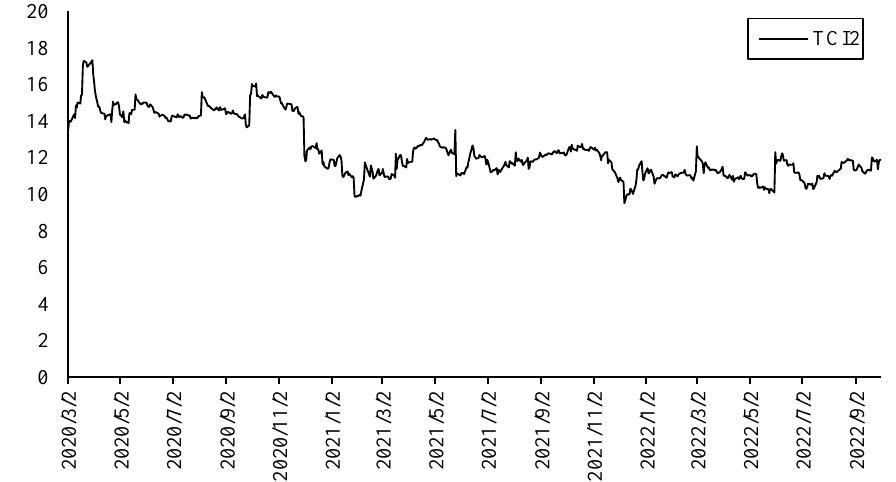
Figure 8. TCI of the second layer (different markets under climate risks).